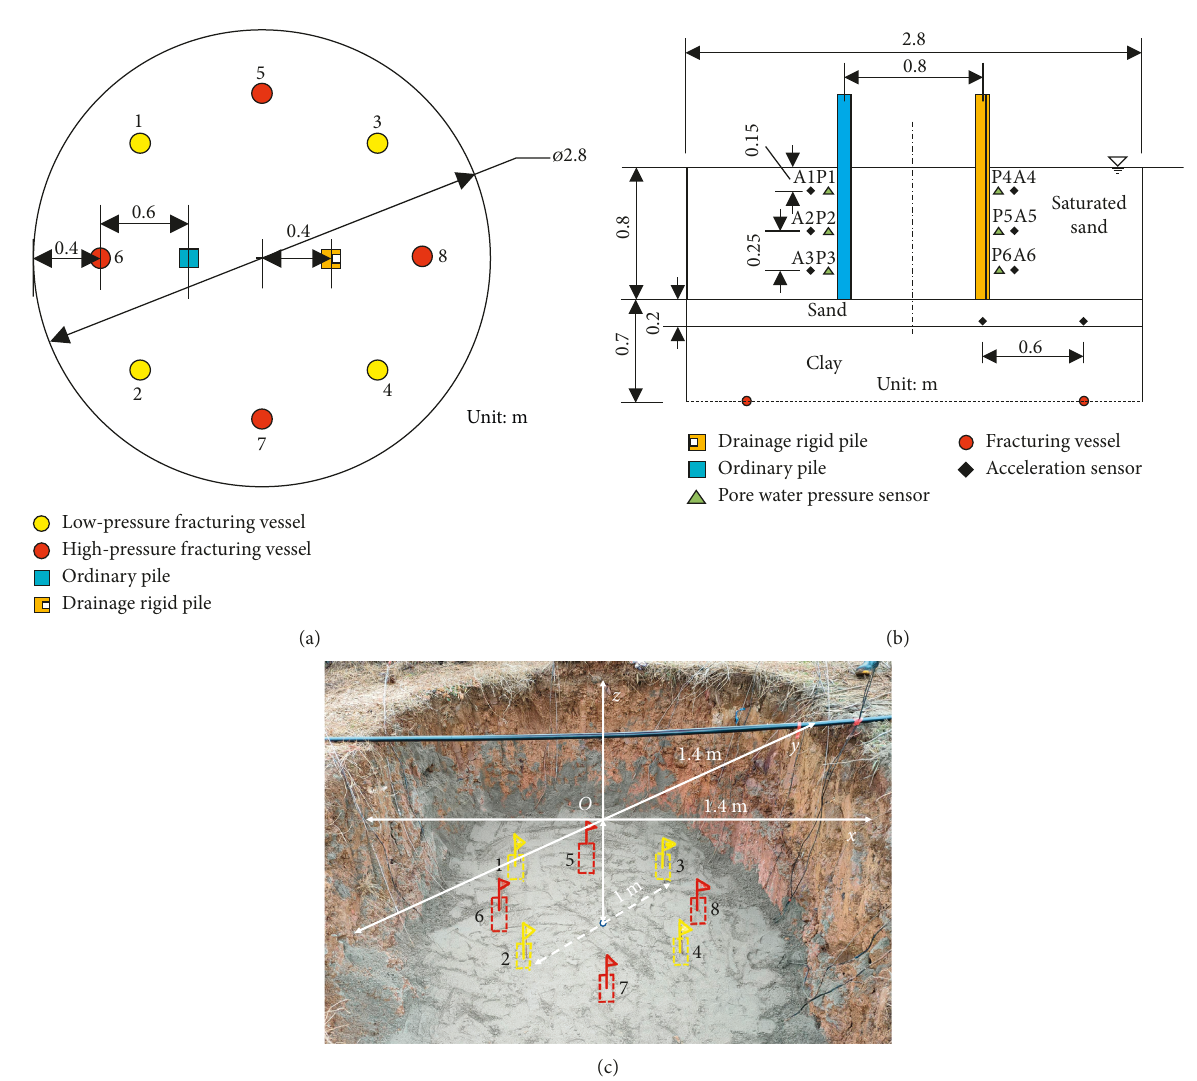
Figure 1: Site set-up scheme. (a) Number and location of the fracturing vessel, (b) site dimensions and equipment layout, and (c) schematic diagram of the actual vessel location Table 1: Basic physical properties of the Yangtze River gray sand. d /mm 60